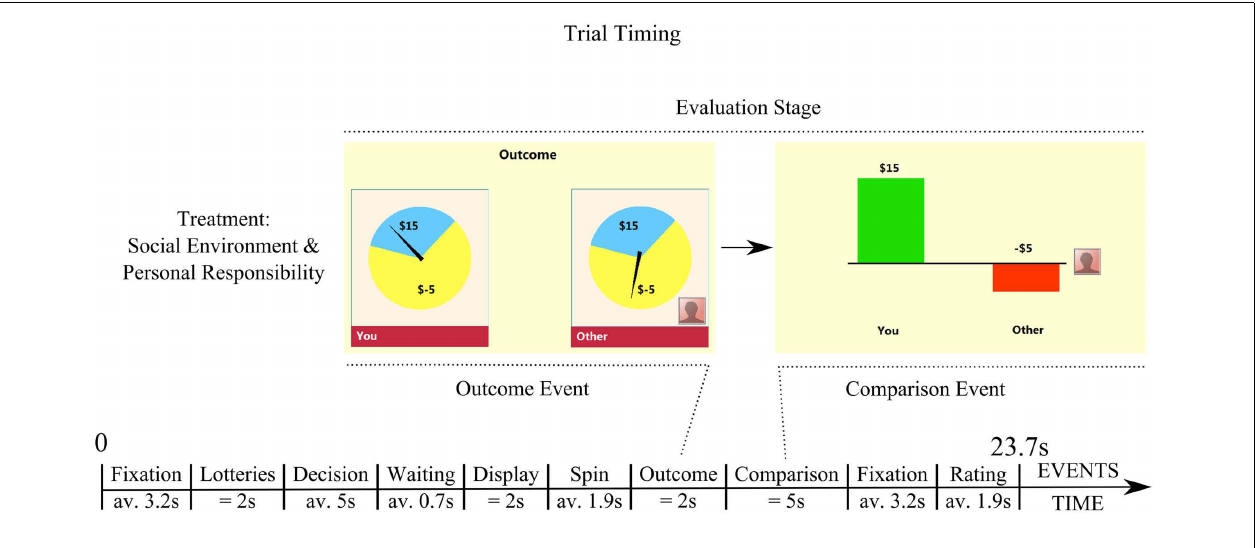
event, a subject (“you”) conducts counterfactual comparison of “ what you got ” as compared to “ what you could have had, but the other got. ”The clause “ but the other got ” extends counterfactual comparison into social